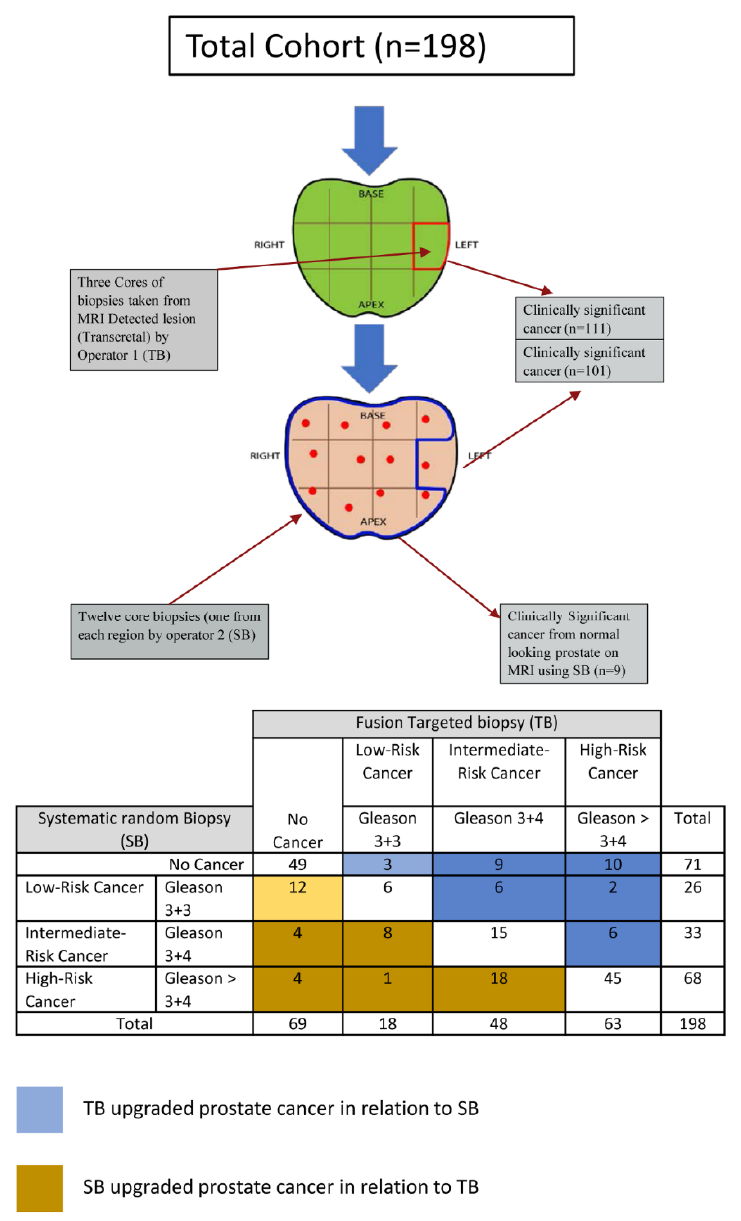
Figure 2. The detection rate of significant prostate cancer between SB and TB based on patients’ level.